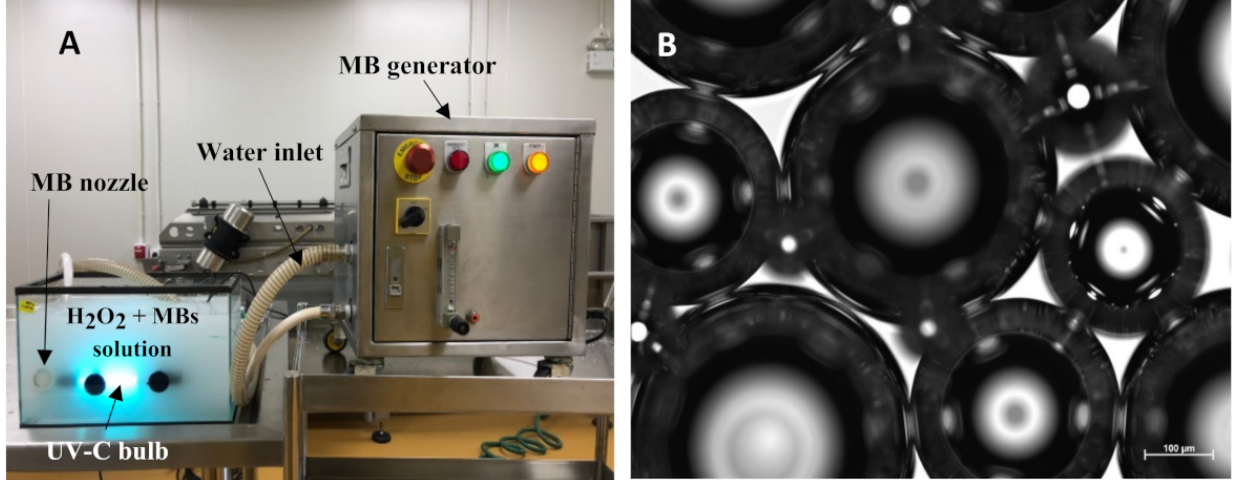
Figure 1. ( A ) The experimental setup for the combined treatment of hydrogen peroxide, UV-C, and MBs. ( B ) The image of MBs (30 to 110 µ m) was taken by the Axiocam 503 mono microscope camera (Carl Zeiss Microscopy GmbH, Berlin, Germany). MB = microbubble; H 2 O 2 = hydrogen peroxide. Bar = 100 µ